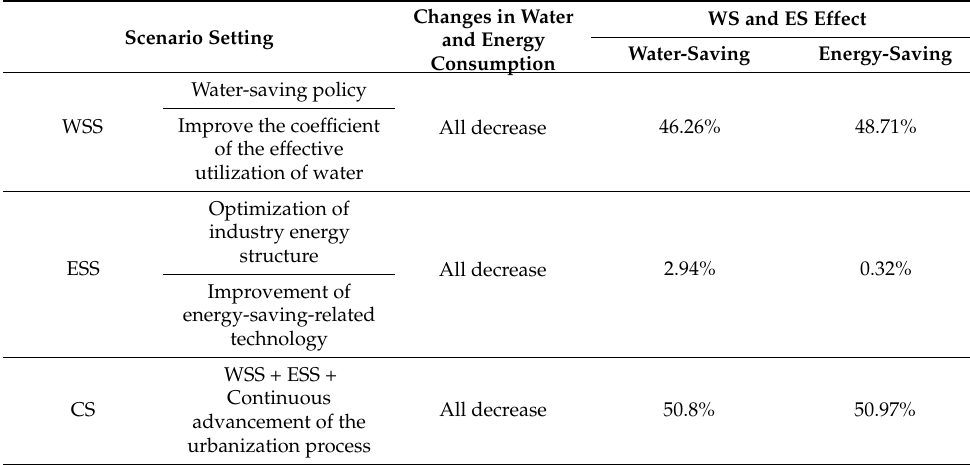
Table 7. The effects of water saving and energy saving in the three simulation